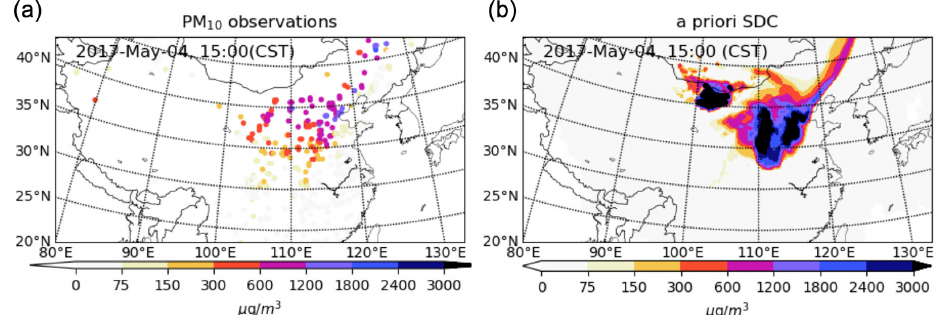
Figure 3. PM 10 observations (a) and the a priori dust simulation (b) at 15:00CST on 4 May. SDC: surface dust